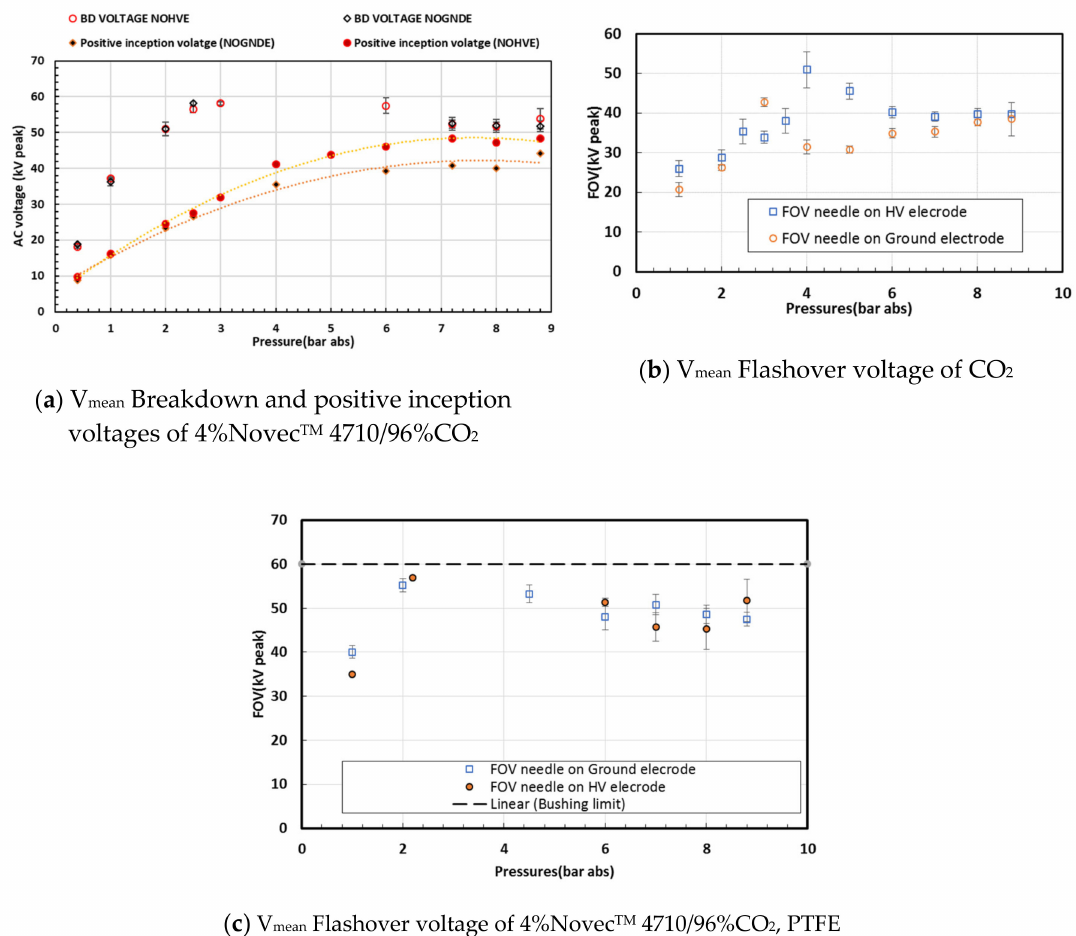
Figure 18. Breakdown / Flashover voltages as function of gas pressure (Needle on HV electrode NOHVE Vs Needle on ground electrode